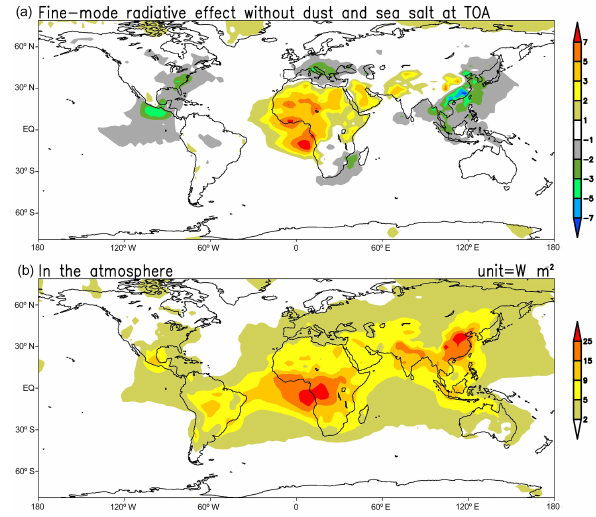
Figure 6. Direct fine-mode aerosol radiative effect without dust and Figure 5. (a) The 2001–2010 mean fine-mode AOD at 550nm sea salt in units of Watts per square meter (baseline); 2001–2010 for sea salt and dust, which is calculated as simulated ra- mean tio × observational large-mode AOD, where the simulated ratio . The obser- refers to Model − mix fine-mode AOD for sea salt and dust Model − mix large-mode AOD for sea salt and dust vational large-mode AOD is computed by integrating AERONET, MODIS and MISR data. Model mix is an optimal mixture of GO- CART, TM5 and ModelE2-TOMAS AOD simulations. (b) Aerosol direct radiative effect due to the sea salt and dust fine-mode aerosols.